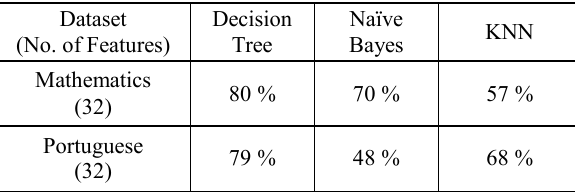
Table 1. Prediction accuracy without feature